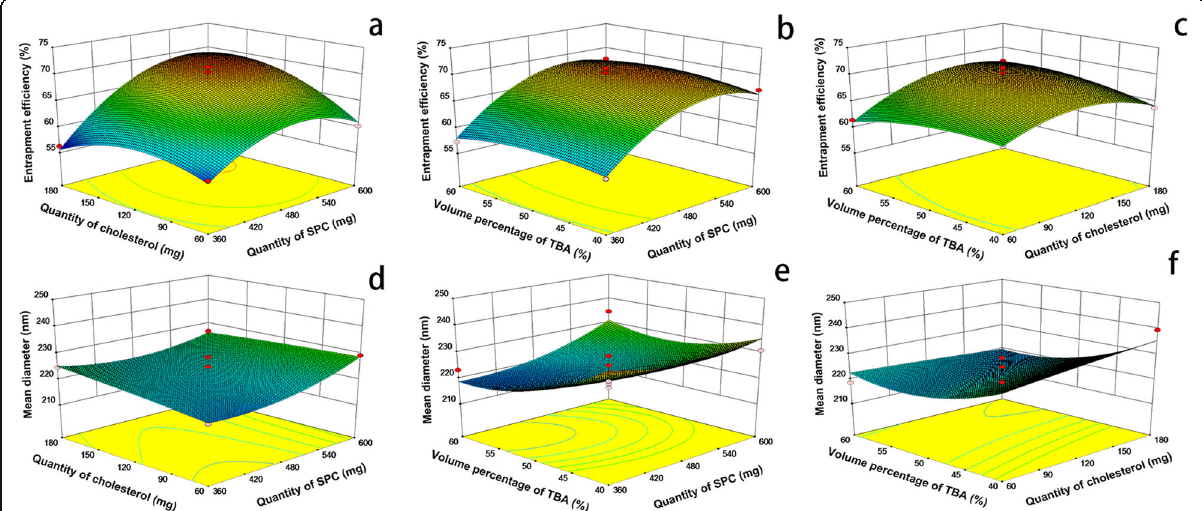
Fig. 8 Three dimensional plots of the effect of X X ( a ), X X ( b ) and X X ( c ) on encapsulation efficiency and the effect of X X (d), X X (e) and X X (f) on mean